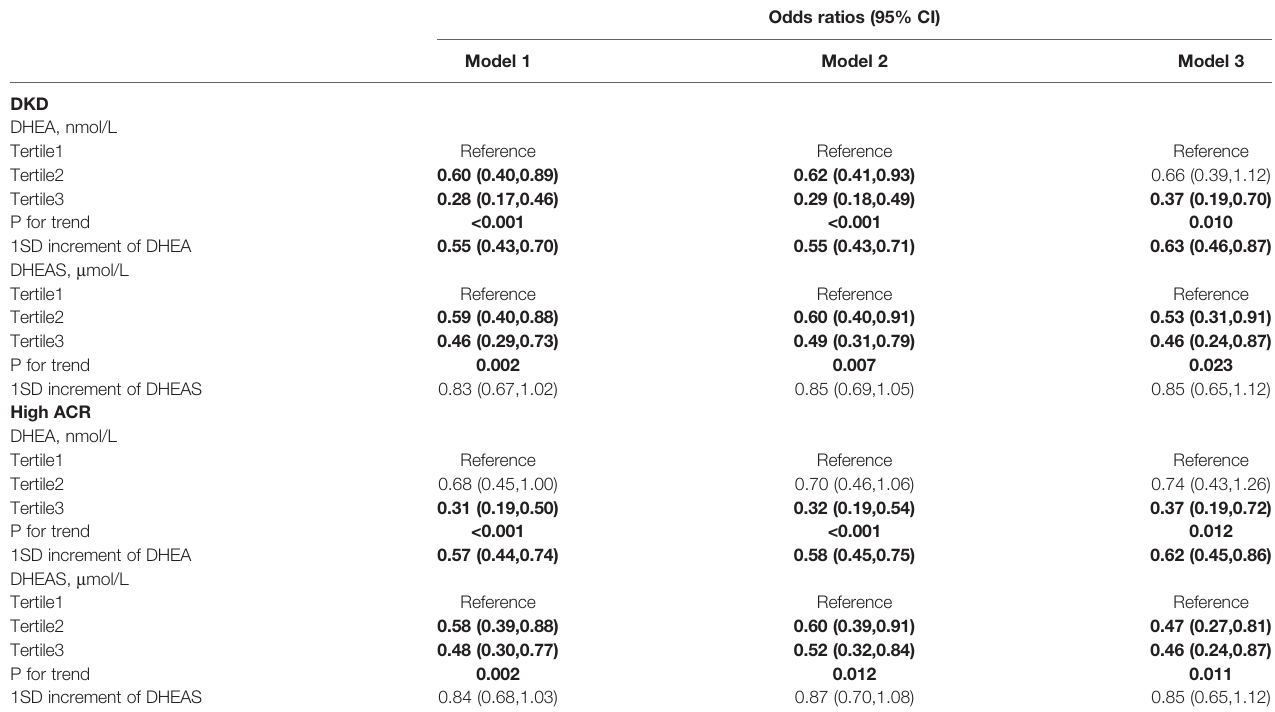
TABLE 2 | Odds ratios of DKD among men by different status of DHEA and DHEAS.